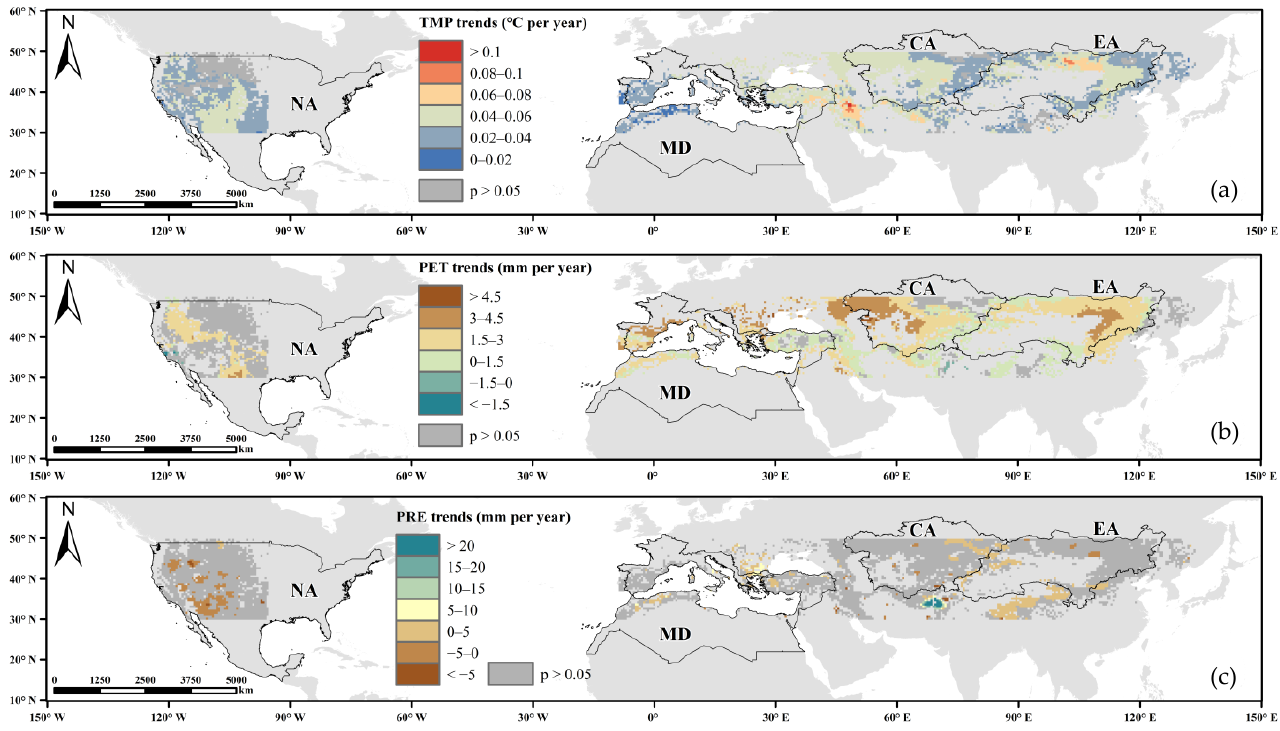
Figure 5. Temporal trends of the average annual t emperature (TMP) ( a ), potential evapotranspira- tion (PET) ( b ), and precipitation (PRE) ( c ) at vegetation distribution grid points from 1981 to 2018.